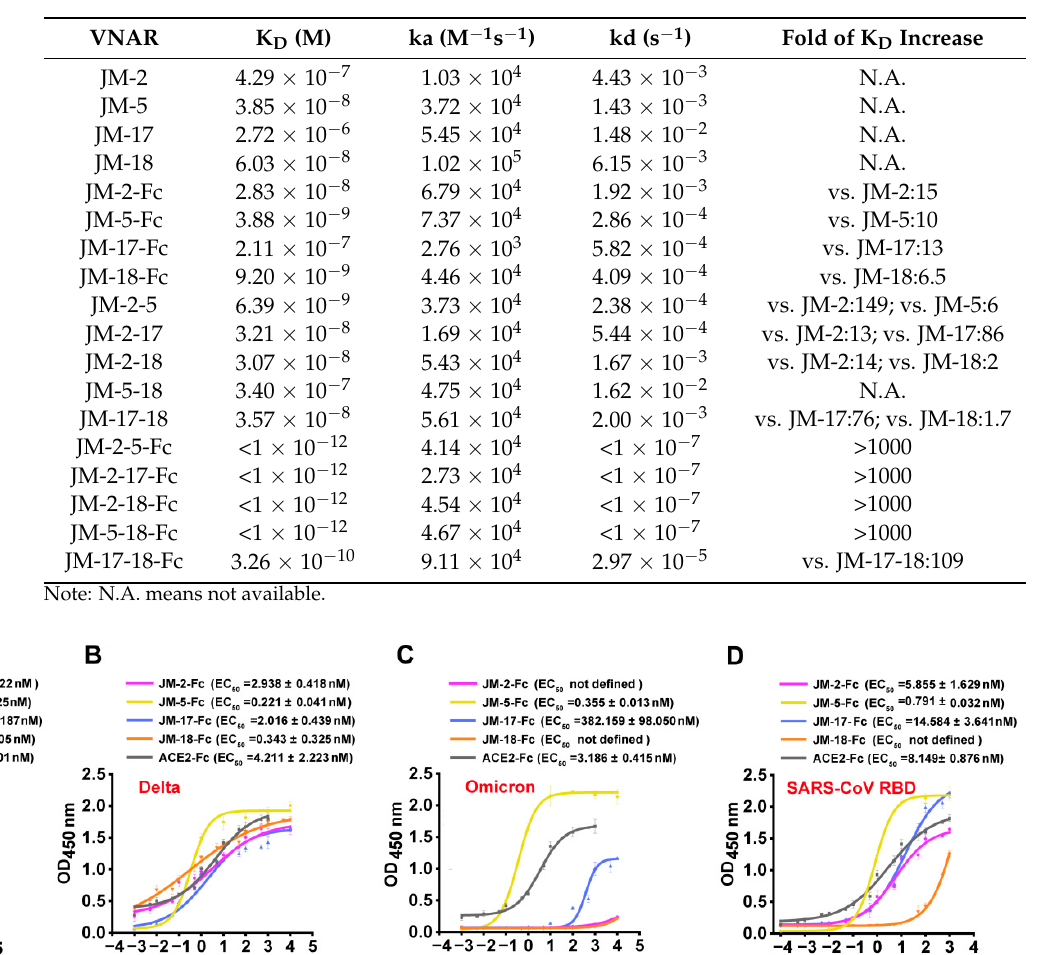
Table 1. K D , ka, and kd values of VNARs, VNAR-Fc fusions, bi-paratopic VNARs, and bi-paratopic VNAR-Fc fusions toward SARS-CoV-2 RBD, and fold of K D increase.